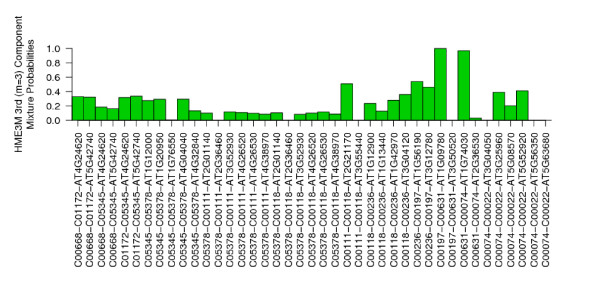
Transition probabilities for the most expressed glycolysis path (m = 3) that separates flowers from rosette for Arabidopsis. Training set CCR = 0.818, AUC = 0.752.